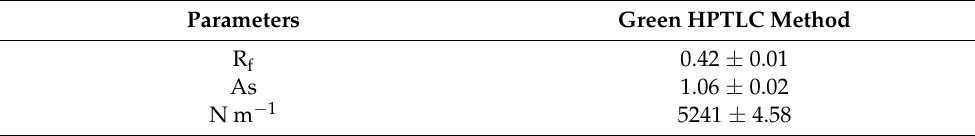
Table 2. System suitability parameters of caffeine for the green HPTLC method (mean ± SD; n = 3).